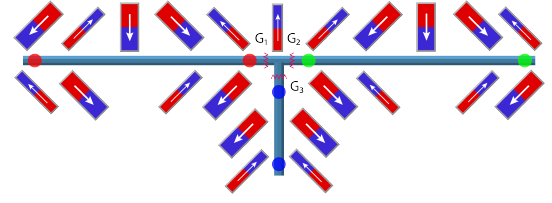
Figure 5: T-Junction setup. The top two sections of nanowire are 5000 nm in length in total and the perpendicular section is 1100 nm. Zigzag lines indicate electrostatic gates. Circles indicate desired positions of 6 MZM with all gates